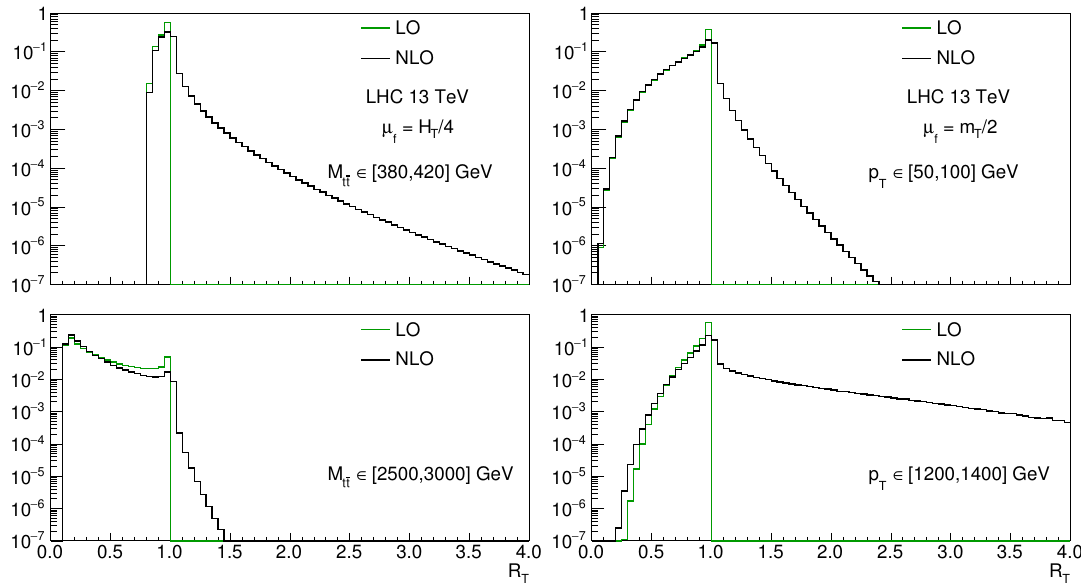
Figure 1 . The distributions of R T = H T =M at LO (green) and NLO (black), in the four regions t (cid:22) t [380 ; 420] GeV (top-left), M [2500 ; 3000] GeV (bottom-left), p T M t (cid:22) t t (cid:22) t 2 2 right), and p T [1200 ; 1400] GeV (bottom-right). The distributions are normalized to the integrated 2 cross section in each of the four